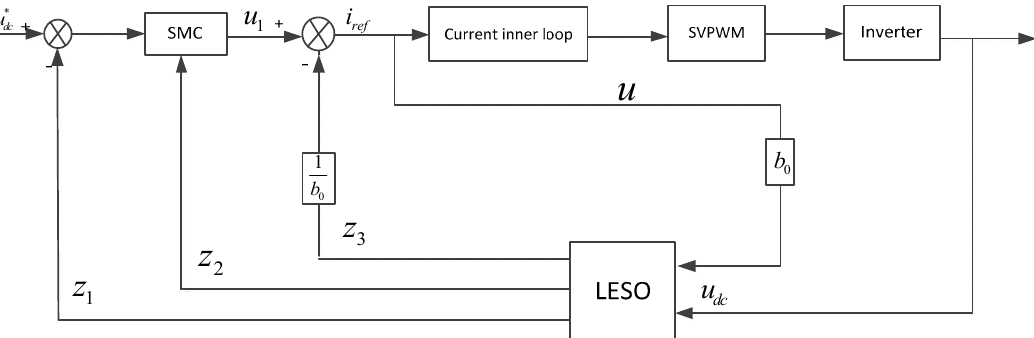
Figure 5. Sliding mode active disturbance rejection control (SMADRC) controller.